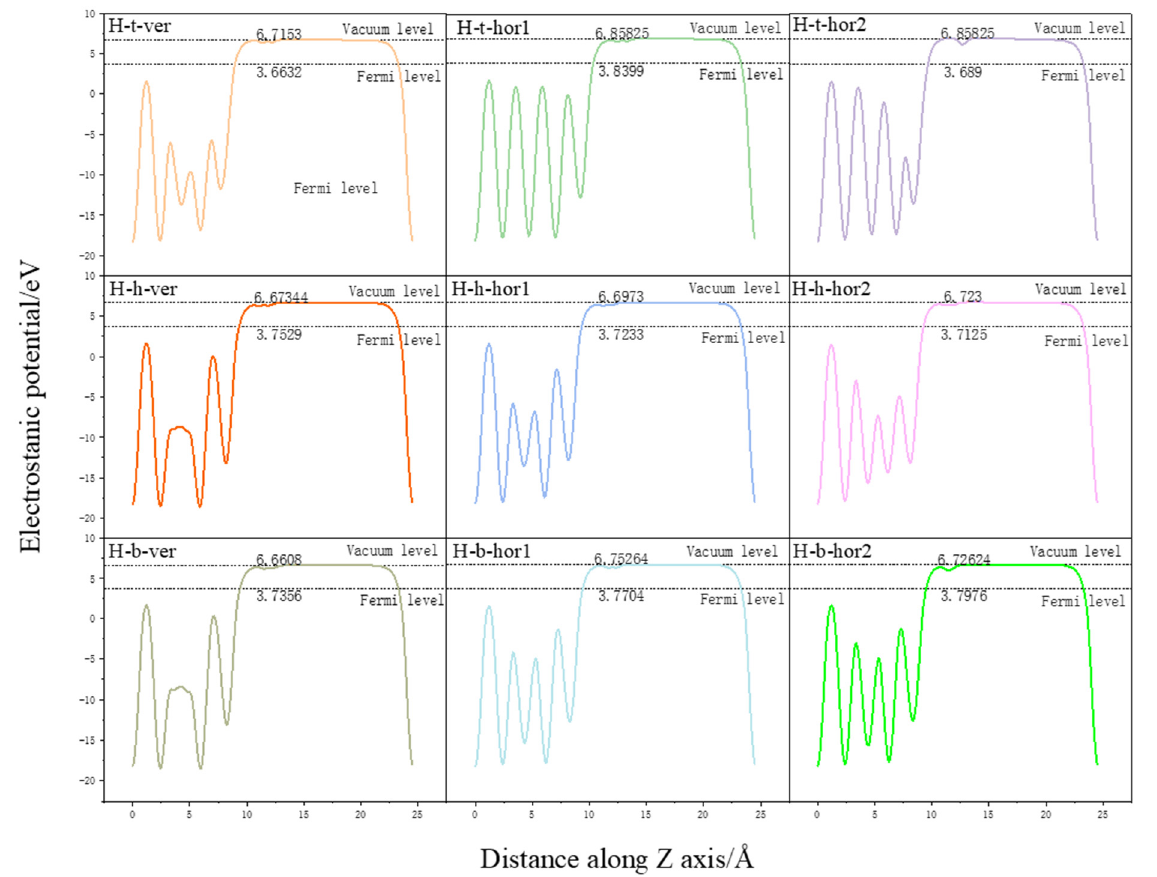
Figure 7. Variation of electrostatic potential along Z-axis for various configurations. Table 3. Variation of surface work function for different adsorption configurations ( ΔΦ ).